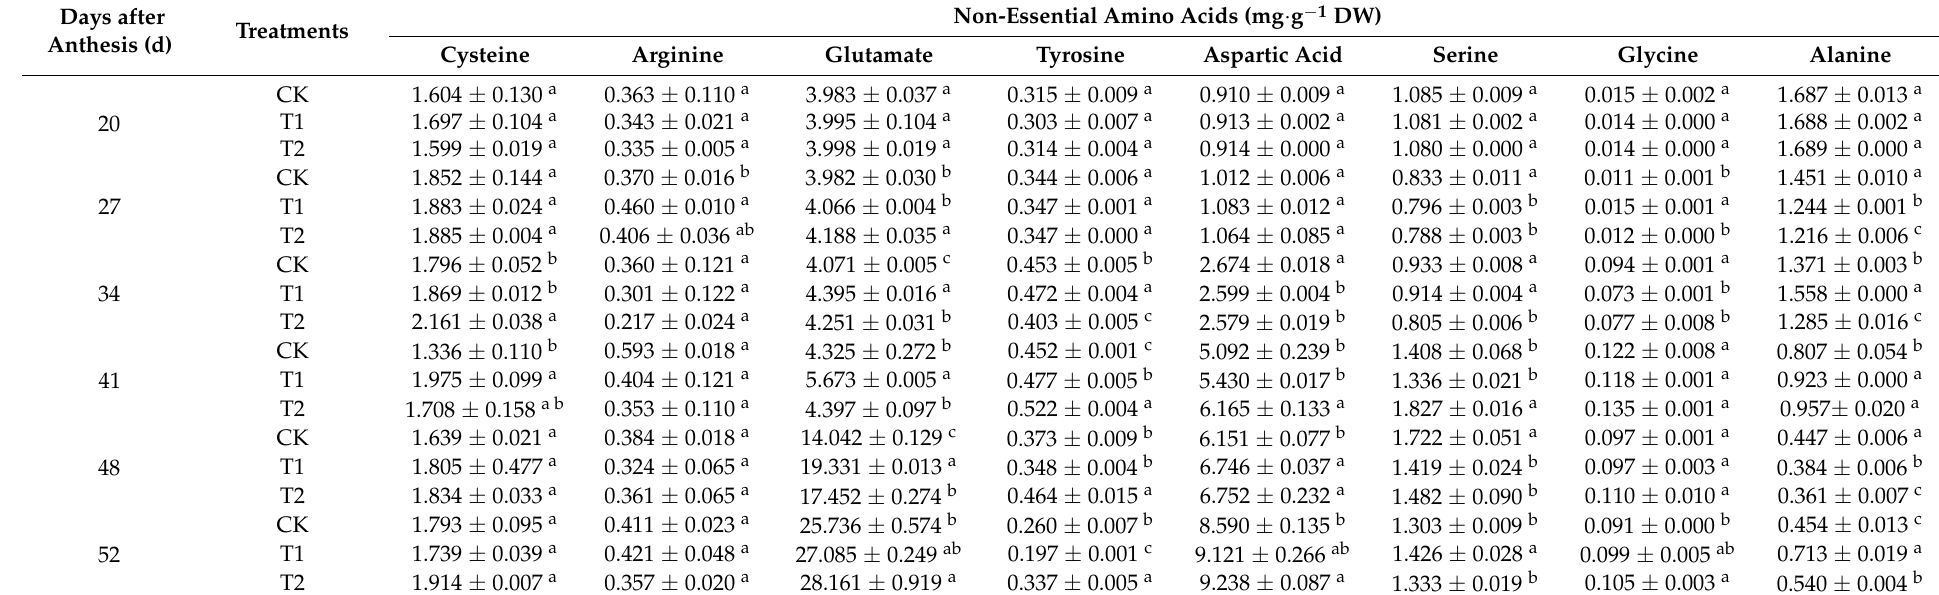
Table 4. Effects of exogenous melatonin on non-essential amino acids of tomato fruit. Days